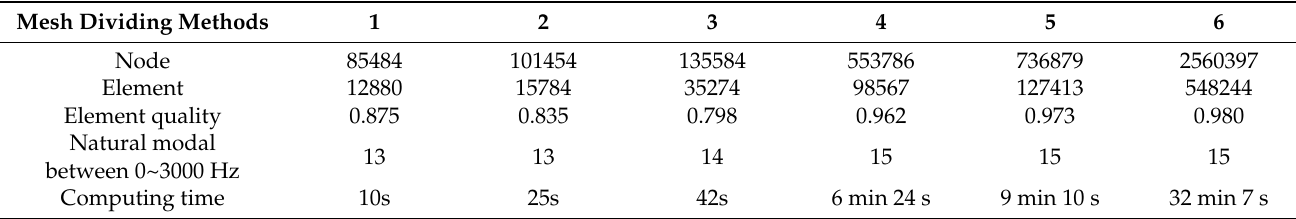
Table 6. The convergence analysis in this